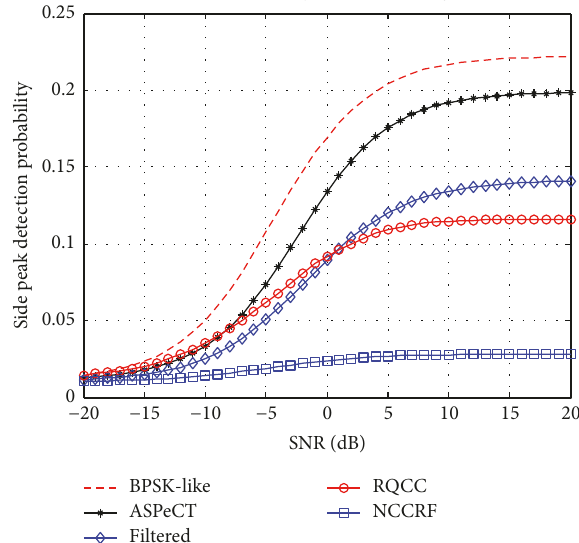
Figure 15: The MPDR comparison of BOC ( 6, 1 ). Side peak detection probability comparison diagram of BOC (2,2)